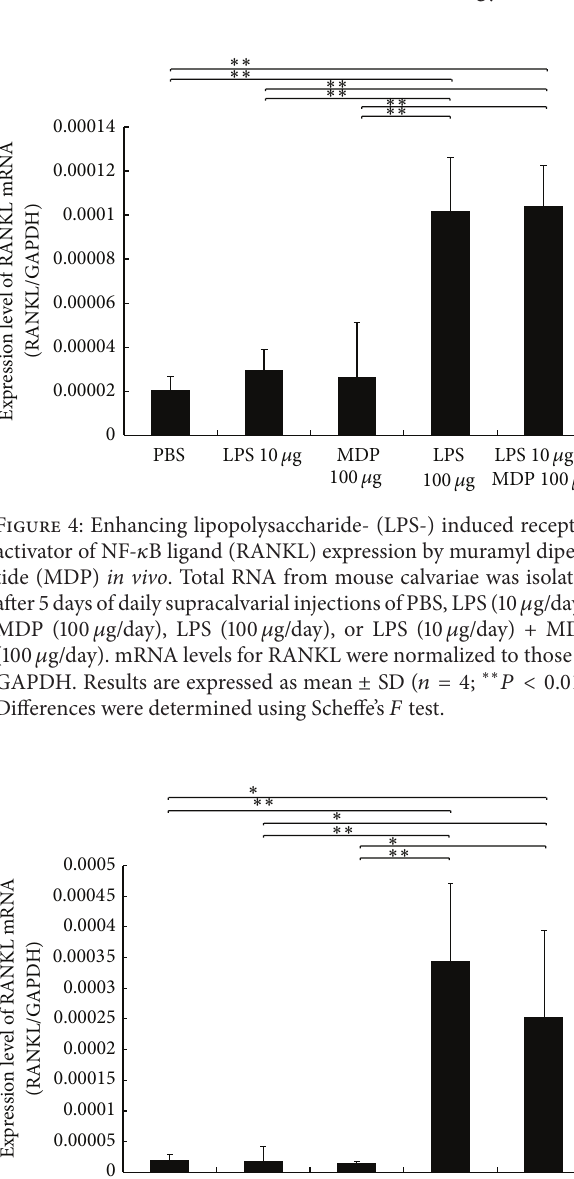
Figure 5: Enhancing lipopolysaccharide- (LPS-) induced recep- tor activator of NF- 𝜅 B ligand (RANKL) expression by muramyl dipeptide (MDP) in stromal cells in vitro . Total RNA from bone marrow stromal cells was isolated after 4 days of incubation in culture medium supplemented with 10ng/mL LPS, 100 ng/mL LPS, or 10ng/mL LPS and 10 𝜇 g/mL MDP. mRNA levels for RANKL were normalized to those of GAPDH. Results are expressed as mean ± SD ( 𝑛 = 4 ; ∗∗ 𝑃 < 0.01 ; ∗ 𝑃 < 0.05 ). Differences were determined using Scheffe’s 𝐹